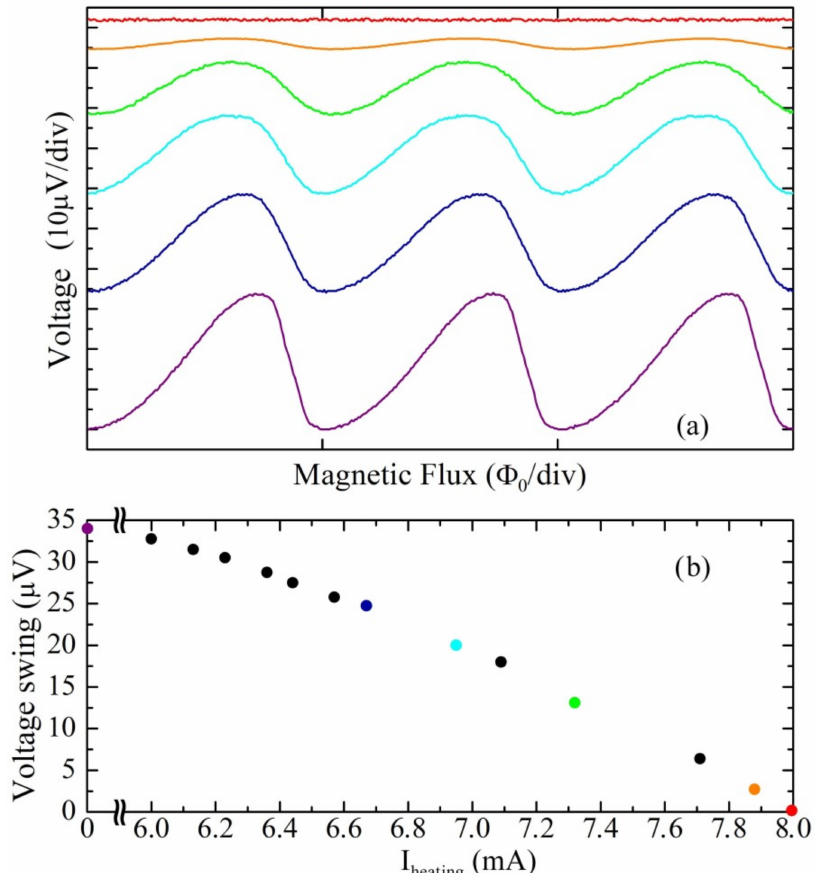
Figure 4. ( a ) Voltage–magnetic flux characteristic (V- Φ ) of a SQUID magnetometer for different heating current measured at liquid helium temperature. ( b ) Amplitude of the voltage swing for different heating currents. The color of each V- Φ curve reported in ( a ) corresponds to the circle with the same color in ( b